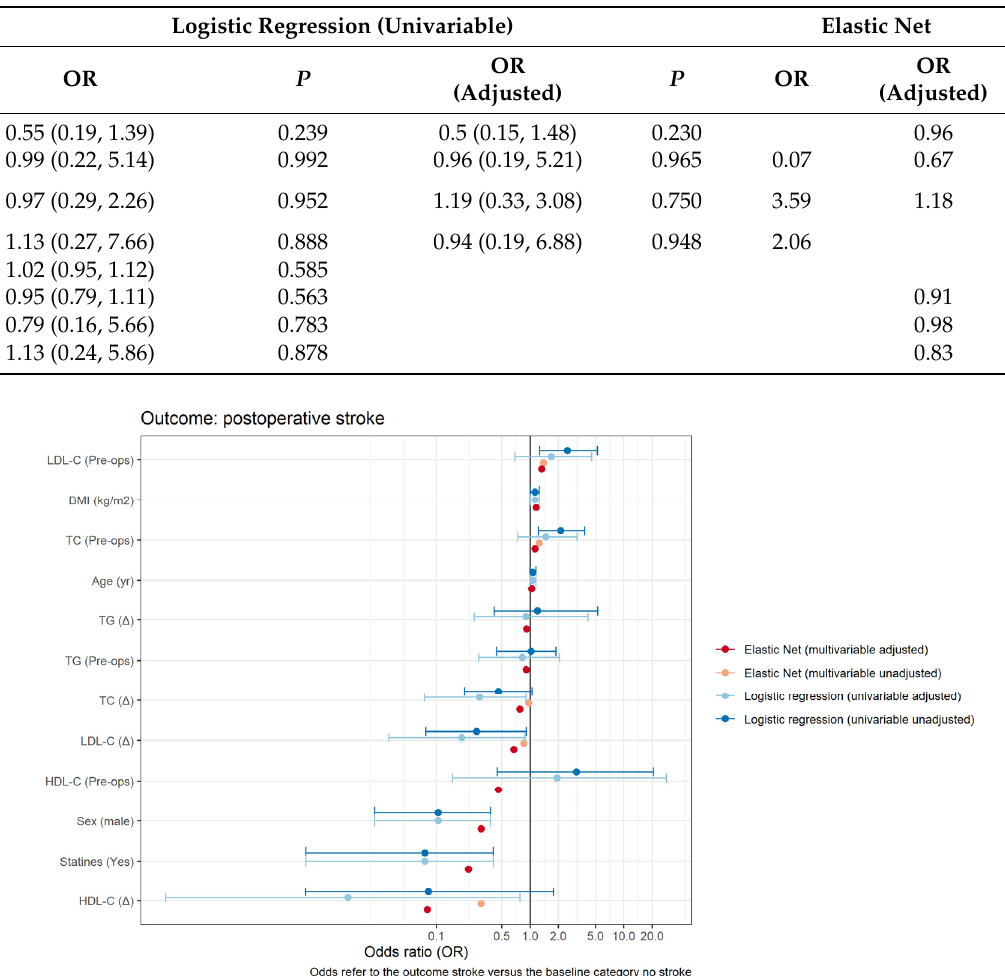
lipids (in units [mmol/L]) and the outcome postoperative stroke in Supplemental Table